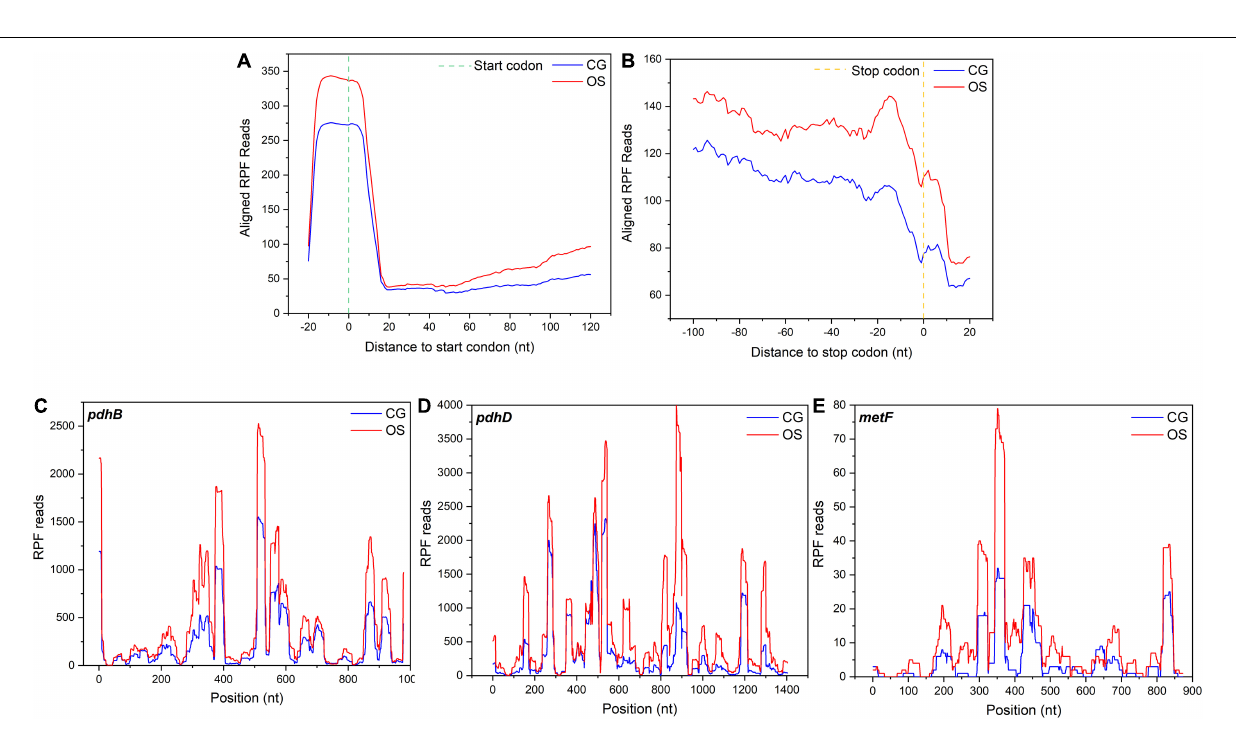
FIGURE 7 | (A) Alignments of RPF reads in the 5 (cid:48) UTR of all mapped genes in a 20-nucleotide distance to start codon. (B) Alignments of the RPF reads in 3 (cid:48) UTR of all mapped genes in a 20-nucleotide distance to stop codon. (C–E) Three representative genes, pdhB , pdhD , and metF , with their ribosome footprint densities increased under osmotic stress in L. rhamnosus ATCC